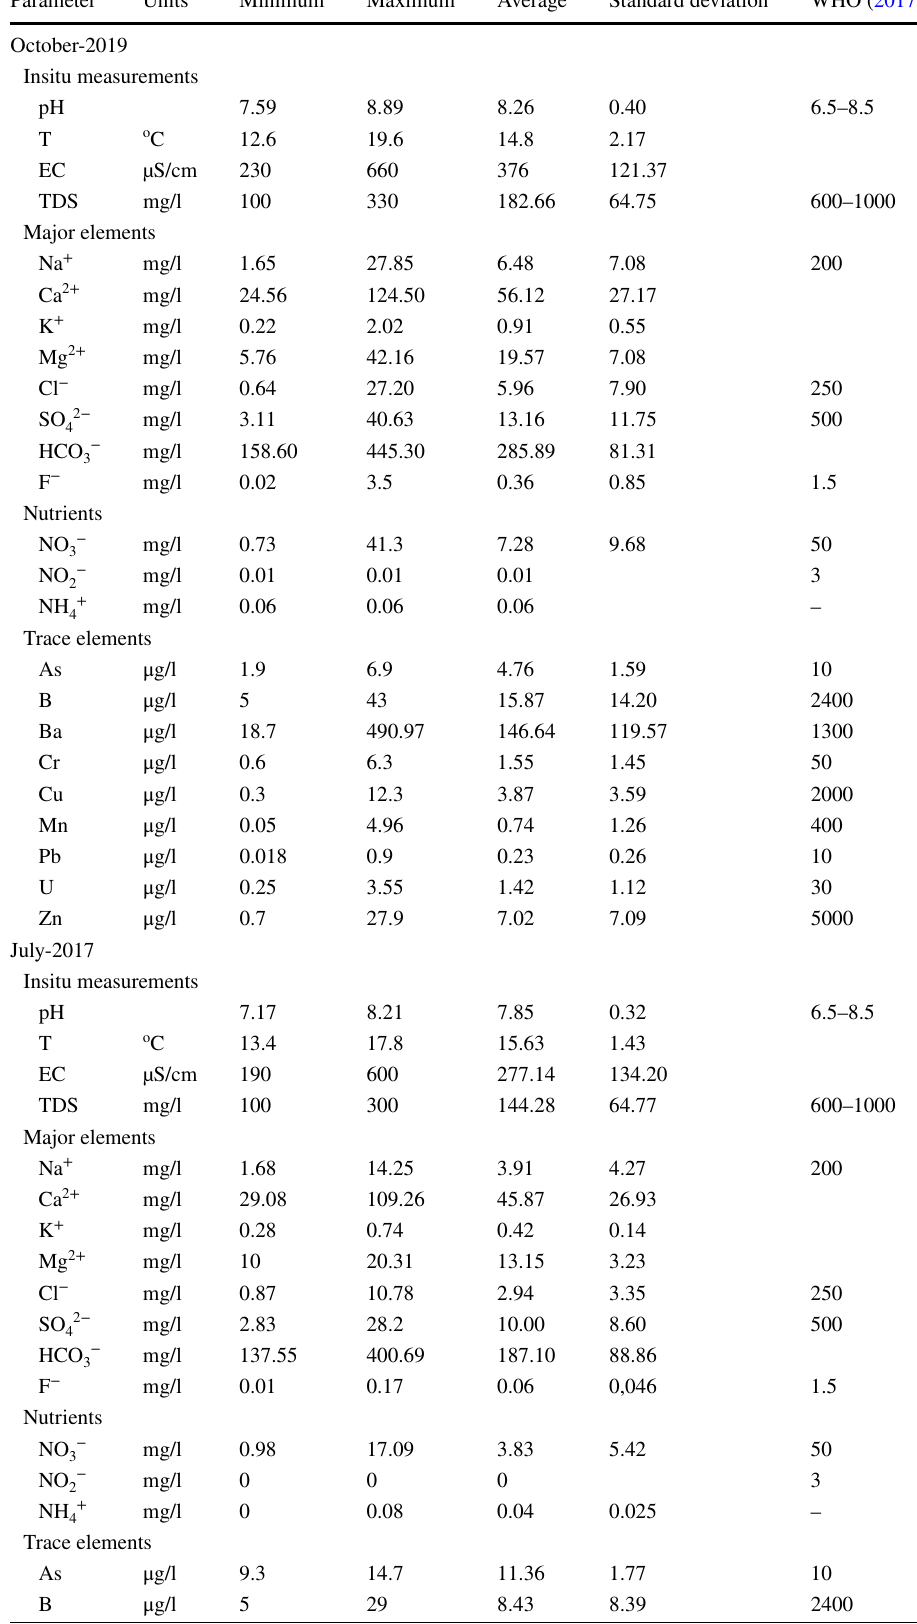
Table 2 Summary statistics